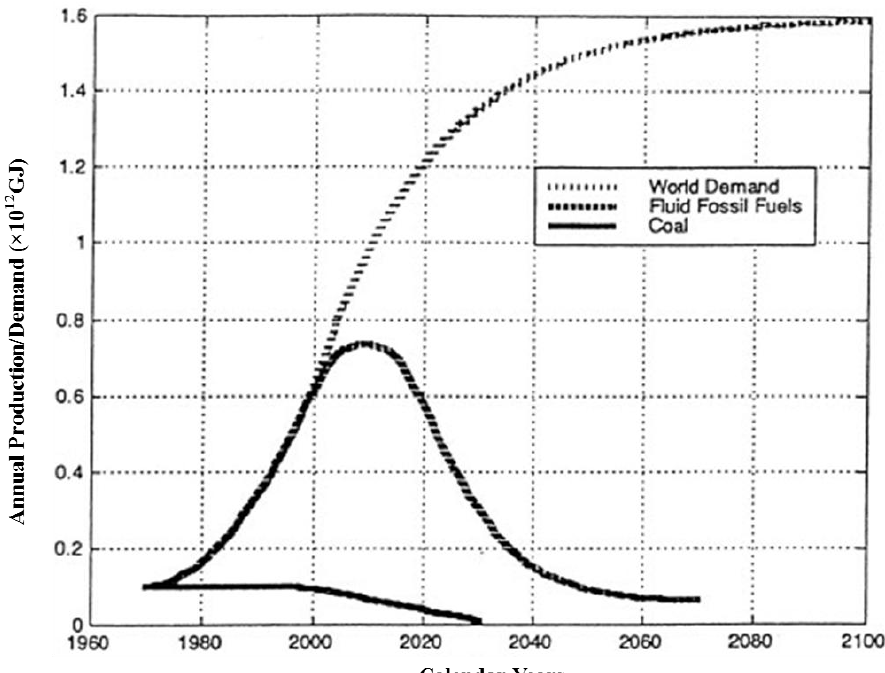
Figure 1. Estimated global energy demand and fossil fuel production